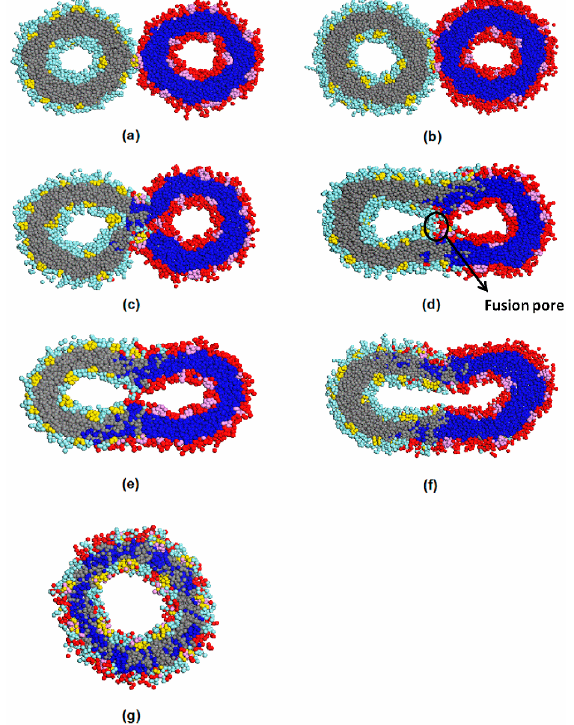
Figure 9. Dynamic of vesicle fusion at ( a ) 250,000 DPD steps; ( b ) 350,000 DPD steps; ( c ) 555,000 DPD steps; ( d ) 660,000 DPD steps; ( e ) 850,000 DPD steps; ( f ) 1,000,000 DPD steps; and ( g ) 20,000,000 DPD steps. Colors of grey and blue, light blue and red, and yellow and pink represent block E, block O, and block F for two different vesicles, respectively. Solvent molecules are omitted for clarity.